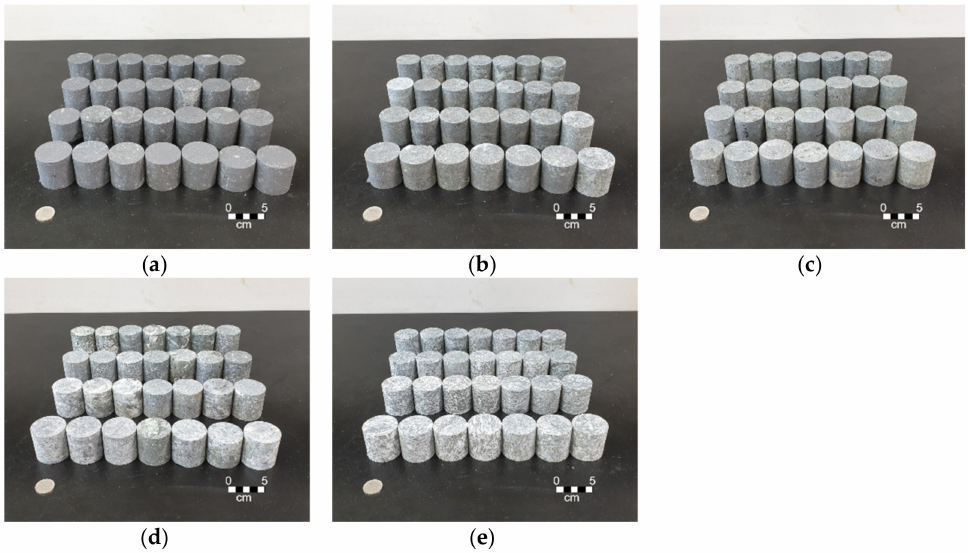
Figure 2. Rock samples of the Gonamsan intrusion for laboratory experiments: ( a ) underground ore, ( b ) discovered ore, ( c ) gabbro, ( d ) monzodiorite, and ( e ) quartz